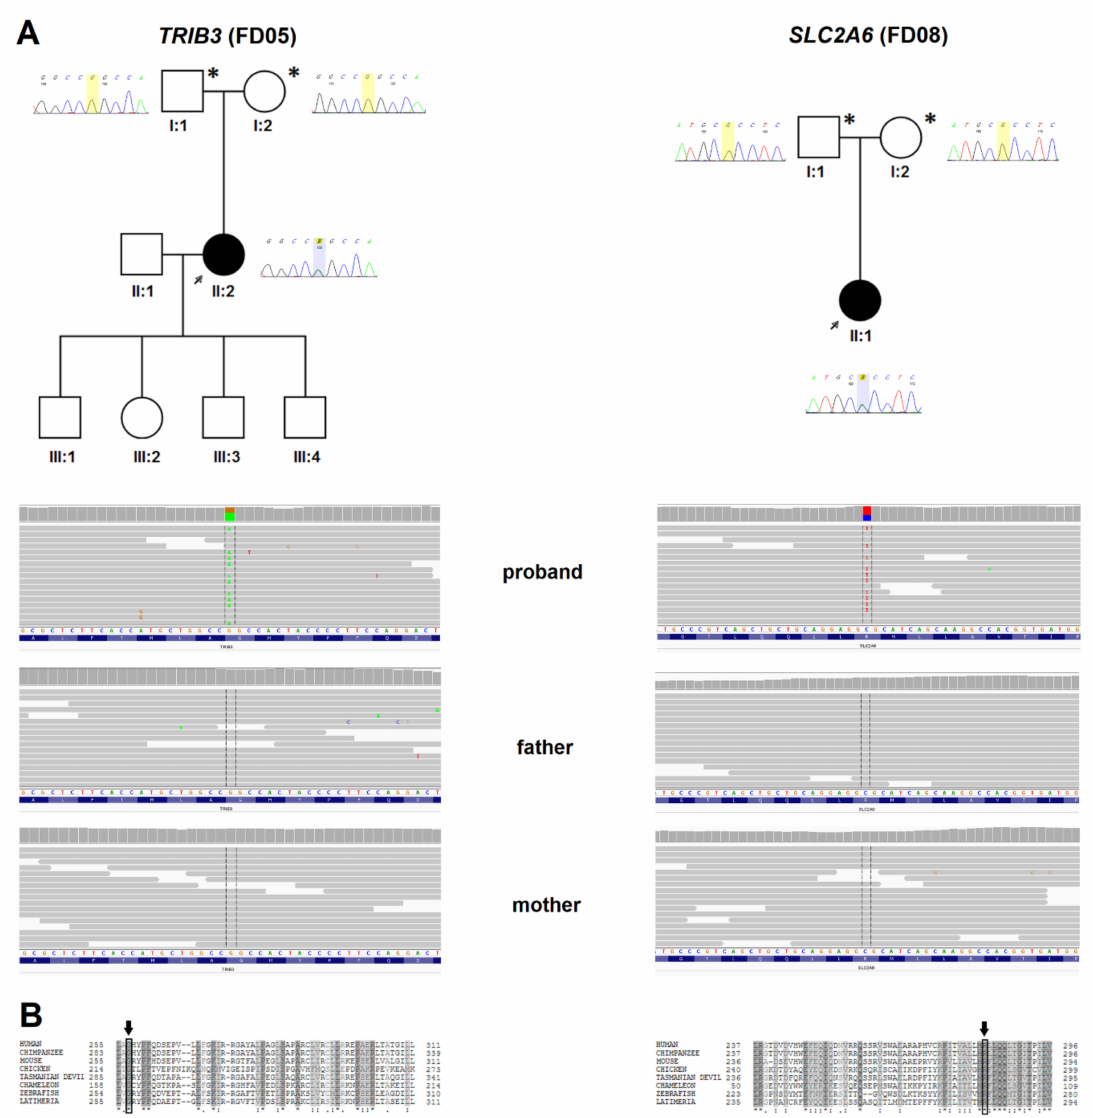
Figure 1. ( A ) The pedigrees of families with de novo variants in novel cardiomyopathy candidate-genes, corresponding Sanger chromatograms, and IGV views in trios. Left: TRIB3 variant p.Gly257Ser / c.769G > A (family FD05); right: SLC2A6 variant p.Arg283His / c.848G > A (family FD08); ( B ) Evolutionary conservation of amino acid residues altered by de novo missense mutations in probands. Aligned UniProt sequences for SLC2A6: #GTR6 ( Homo sapiens ), #H2R2P8 ( Pan troglodytes ), #A2AR26 ( Mus musculus ), #F1NAR8 ( Gallus gallus ), #G3VXJ7 ( Sarcophilus harrisii ), #H9GLX0 ( Anolis carolinensis ), #F1RB41 ( Danio rerio ), #H3AT68 ( Latimeria chalumnae ), and for TRIB3: #TRIB3 ( Homo sapiens ), #H2QJS5 ( Pan troglodytes ), #TRIB3 ( Mus musculus ), #R4GLD1 ( Gallus gallus ), #G3VRY0 ( Sarcophilus harrisii ), #H9GDK2 ( Anolis carolinensis ), #F1QCV8 ( Danio rerio ), #H3AA74 ( Latimeria chalumnae